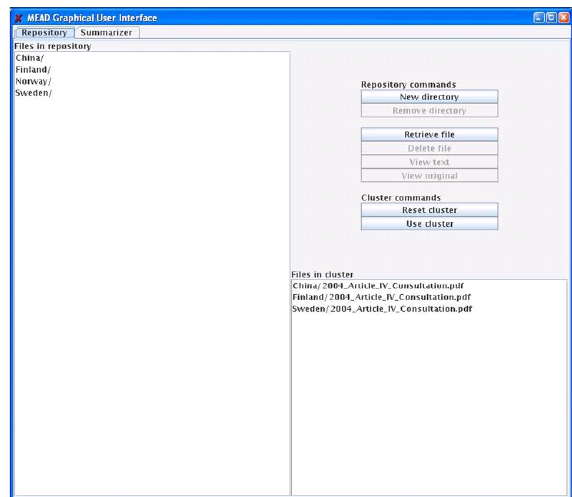
Fig. 1. MEAD-GUI repository window